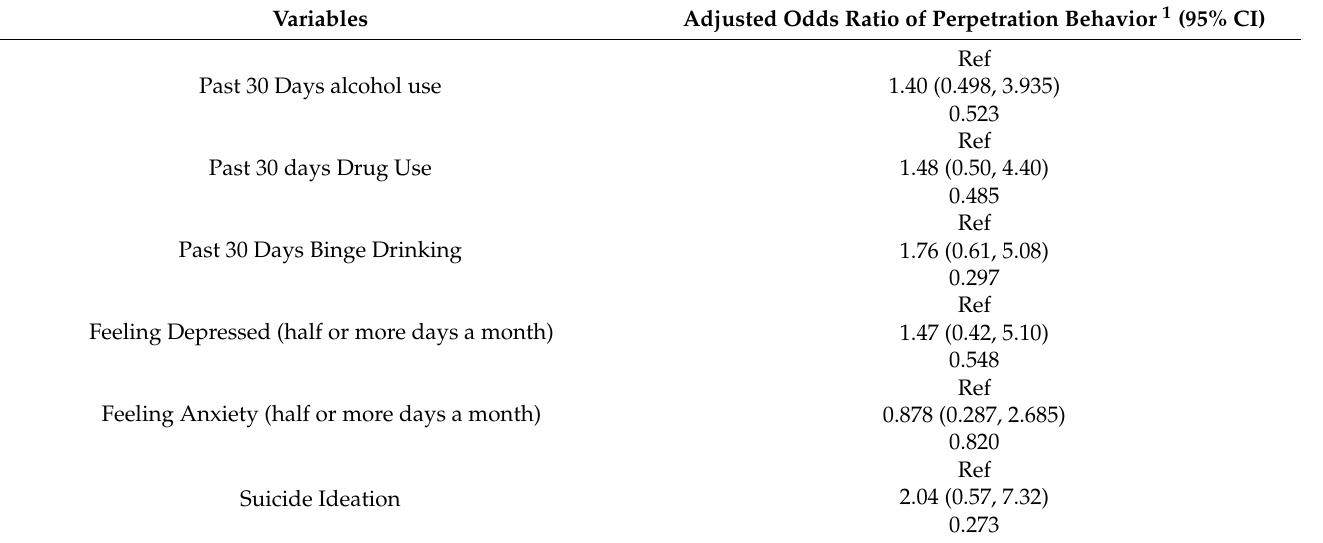
Table 4. IPV Perpetration and Association with Substance Use, Mental Health, and IPV Victimization: Findings from Logistic Regression Models Further Adjusted for IPV Victimization ( n =